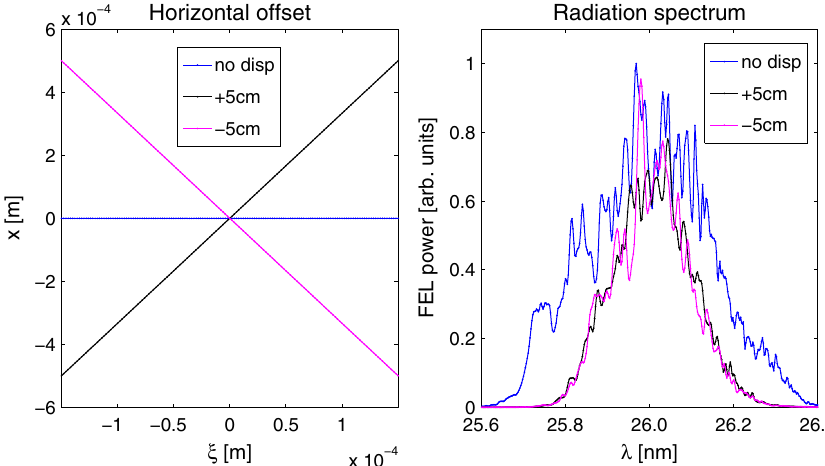
FIG. 10. (Color) Dispersion effects on the wavelength spectrum for an initial zero offset along the bunch.